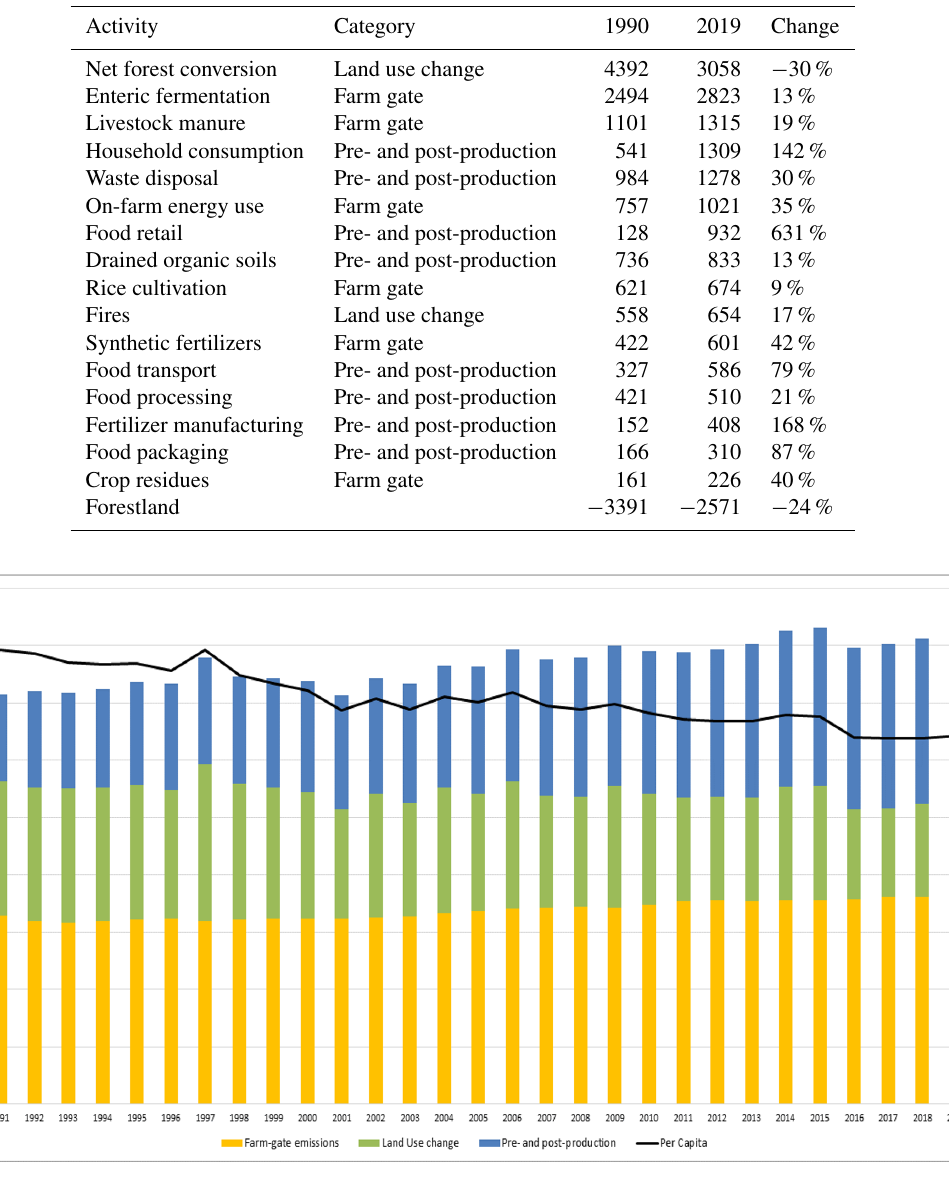
Figure 2. World total GHG emissions from agri-food systems, 1990–2019. Color bars show contributions by emissions within the farm gate (yellow); land use change (green) and pre- and post-production along food supply chains (blue). Source: FAOSTAT (FAO, 2021a). Also shown are emissions per capita (authors’ own